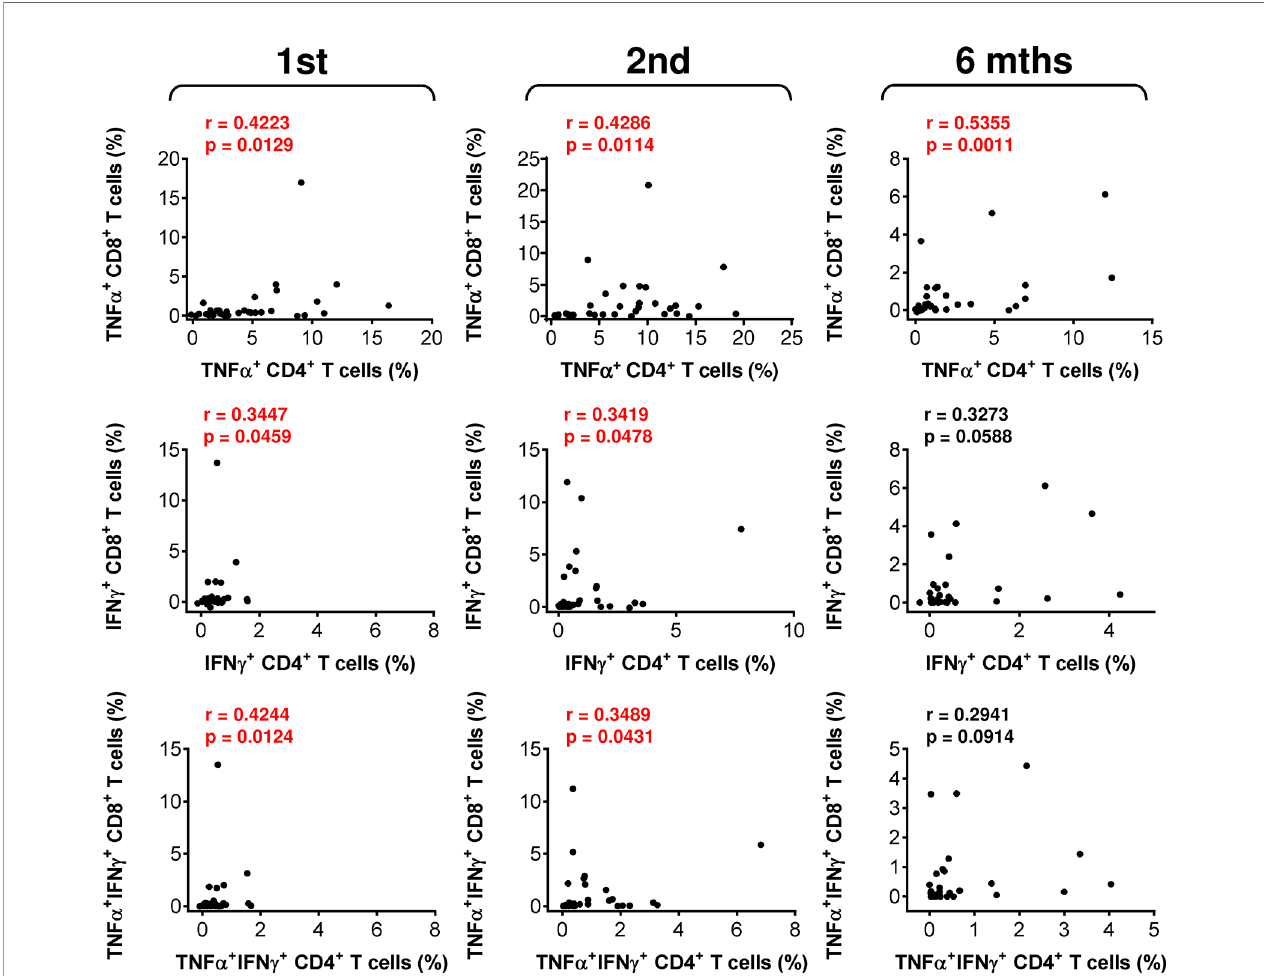
FIGURE 3 | The associations between SARS-CoV-2 spike glycoprotein peptide-speci fi c CD4 + and CD8 + T-cell reactivity during and after vaccination. The correlations between the frequencies of peptide-reactive TNF a -, IFN g -, or TNF a /IFN g -producing CD4 + and CD8 + T cells before (1st) and 4 weeks (2nd) and 6 months (6 mths) after the second vaccine dose was administered. Spearman ’ s rank-order correlation coef fi cient (r) and the signi fi cance ( p value; n = 34) are